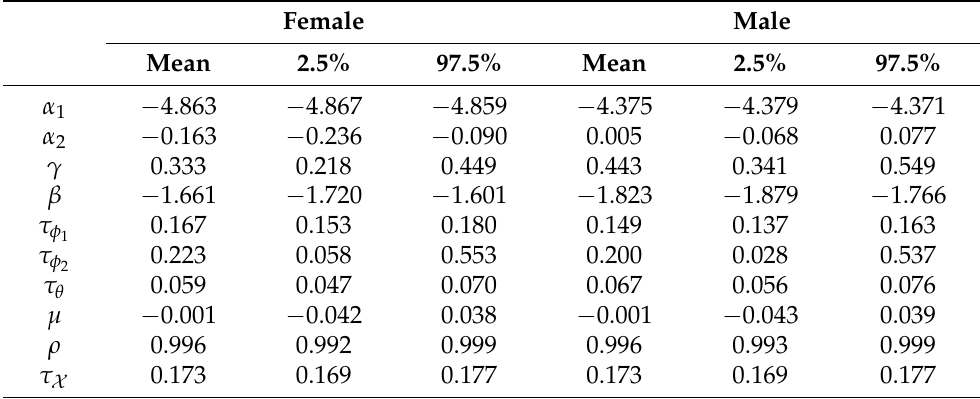
Table 4. Summary of posterior distributions of scalar parameters in the male and female county mortality models.